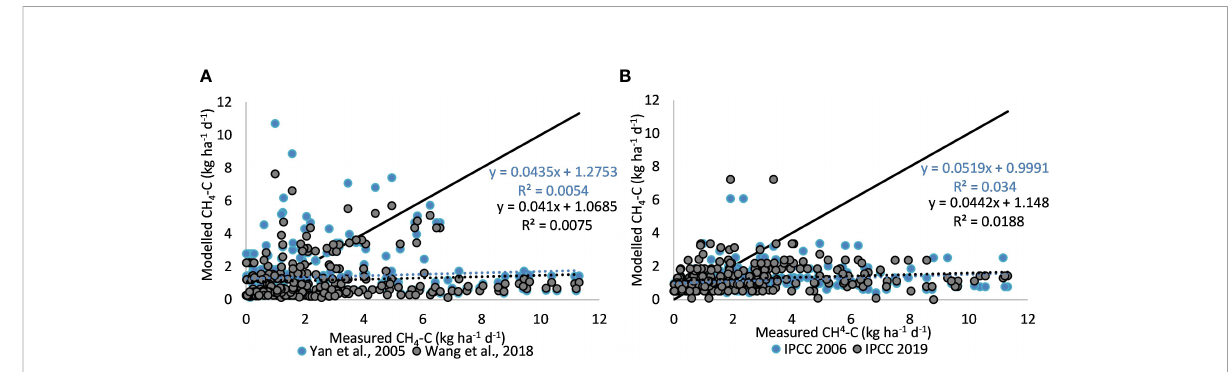
FIGURE 3 Modelled and observed CH4 emission for Southeast Asia: (A) Yan and Wang tier 3 models, (B) IPCC tier 1 models (solid line indicates 1:1). Sample size n =